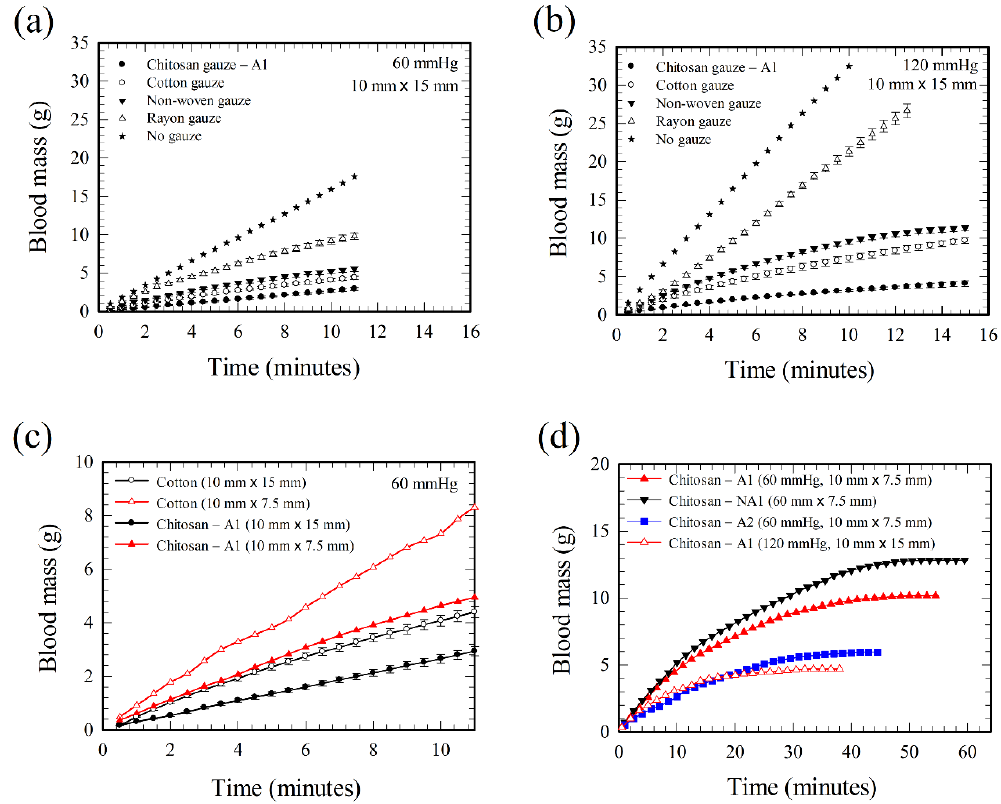
Figure A2. Hemostatic performance of gauzes using the CPG device. ( a , b ) Time evolutions of the blood mass through different gauzes under different pressure gradients associated with pressure heads 60 and 120 mmHg, respectively. ( c ) Effect of gauze size on the blood mass through the cotton and chitosan gauze—A1. ( d ) Effect of base weight, acidification, and gauze size on the blood mass through various chitosan-based gauzes. All the measurements were performed using whole blood– 1.